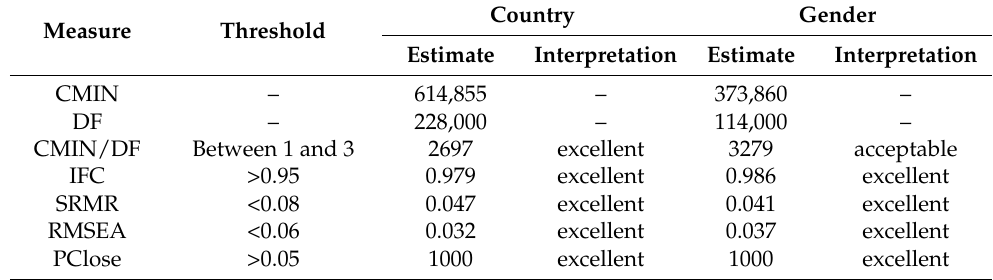
Table 10. Configural invariance.